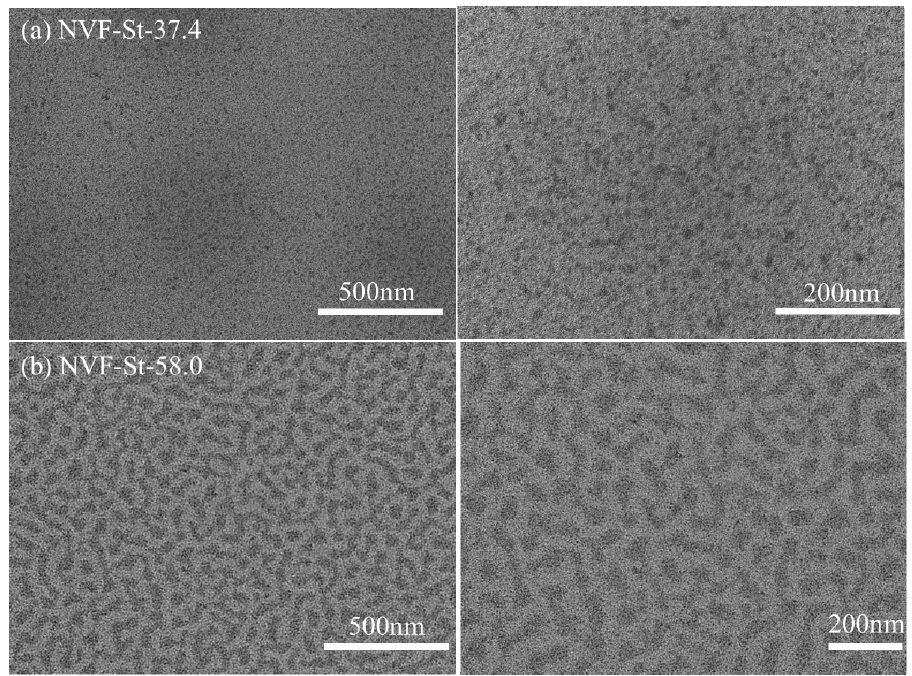
Figure 4. Transmission electron microscopy (TEM) images of ( a ) NVF-St-37.4 (No.2) and ( b ) NVF-St-58 (No.6) dyed with RuO 4 .